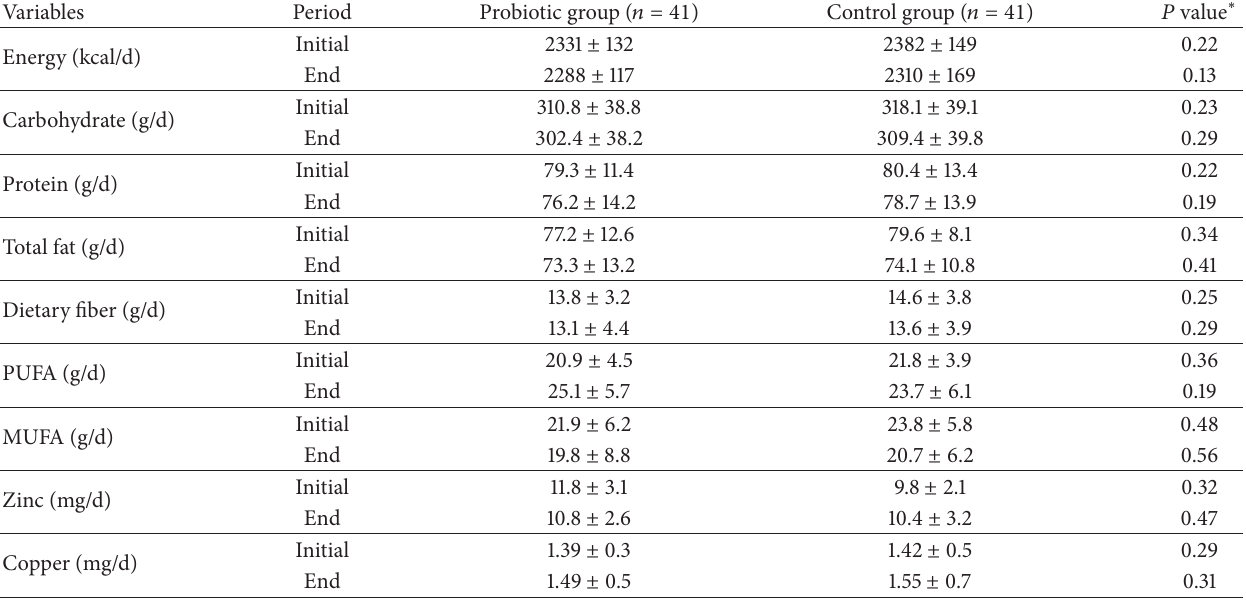
Table 2: Dietary intakes of the intention-to-treat participants at baseline and at the end of the study. Variables